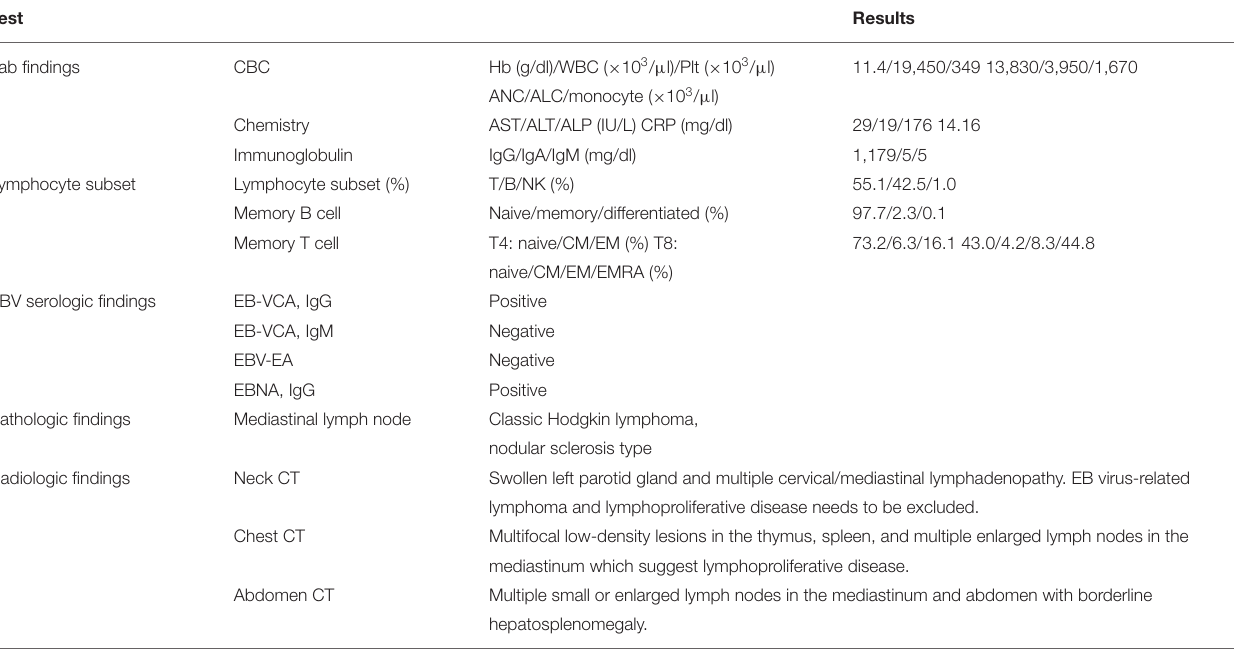
TABLE 1 | Clinical characteristics and laboratory, radiologic, and pathologic findings of the patient at initial diagnosis. Test Results